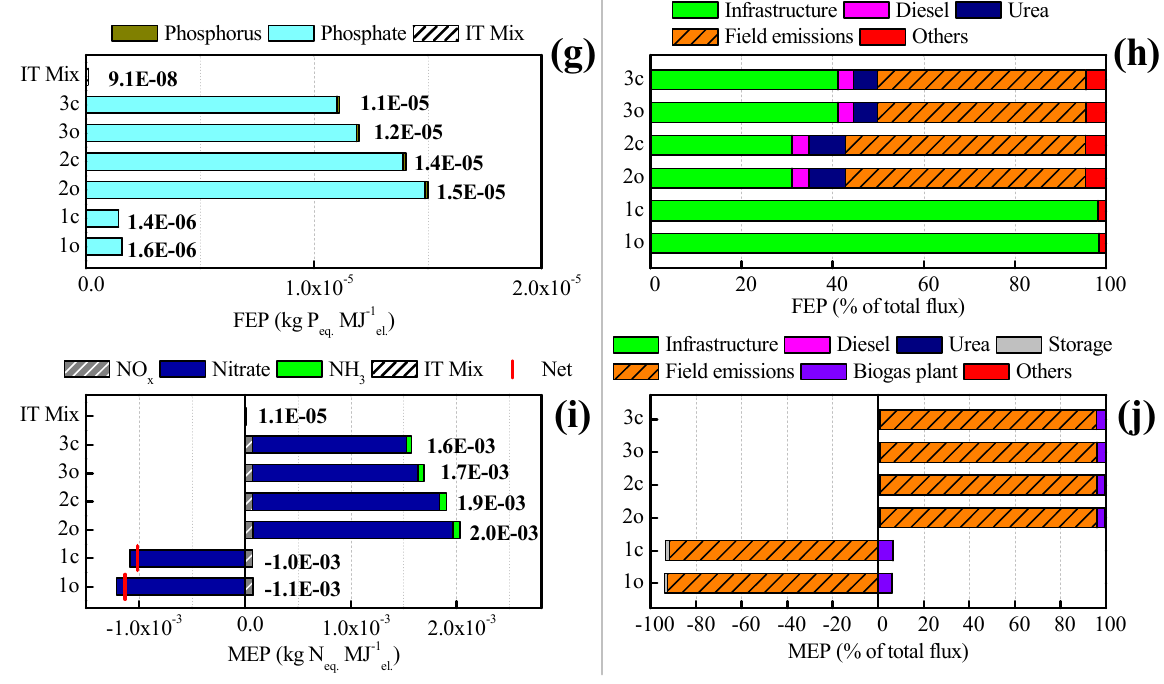
Figure 4. ( a ) Substances contribution to the Acidification Potential (AP) (in moles of H + eq ·MJ − 1 el ). Thick red line symbols represent the net impact for manure pathways; ( b ) Process contribution for the AP impact. The percentage values are referred to the total fluxes; ( c ) Substances contribution to Particulate Matter/Respiratory Inorganics (PM/RI) the total fluxes); ( e ) Substances contribution to Photochemical Ozone Formation Potential (POFP) in kg NMVOC eq ; ( f ) Process contribution of POFP emissions (in% of the total fluxes); ( g ) Substances contribution to Freshwater Eutrophication Potential